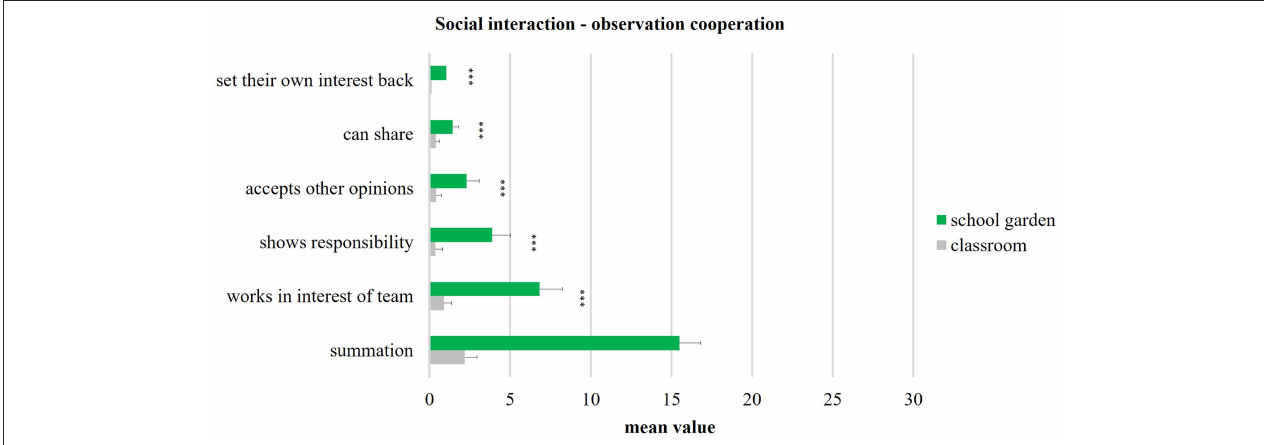
FIGURE 9 | Social interaction - cooperation (school garden n = 82, classroom n = 68). Significance p different levels (* p < 0.05; ** p < 0.01; *** p <